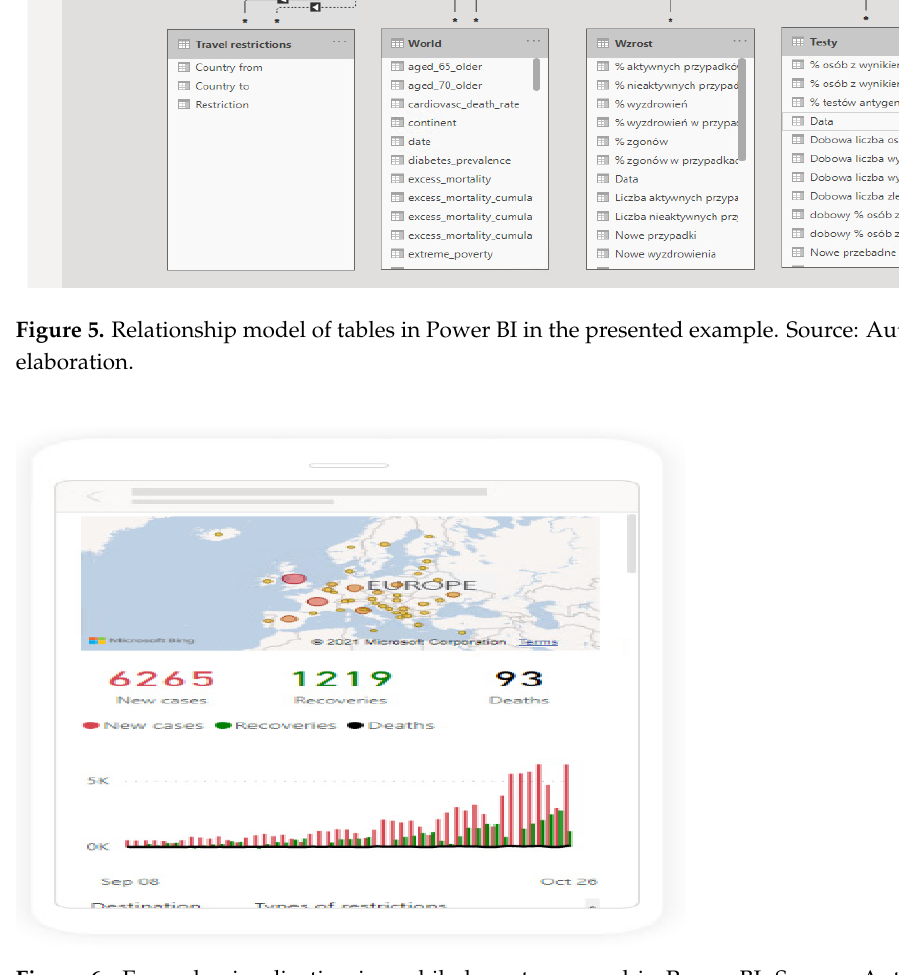
Figure 6. Example visualization in mobile layout prepared in Power BI. Source: Authors own elab- oration.